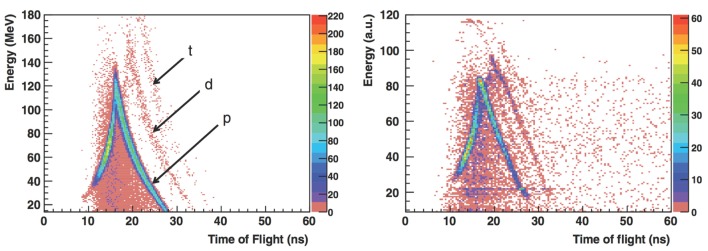
From Ref. (27): energy vs. time of flight (expressed in nanoseconds) distributions obtained for 310 MeV/u carbon ions incident on a 21-cm-thick water target with the telescope located at 30° with respect to the beam direction at 2.2 m from the target center. Left: simulation with Geant v.4 9.2 toolkit, right: measurements (GSI experiment). p, d, and t refer to protons, deuterons, and tritons in the simulated distributions (the background events are mainly due to fragmentation reactions in the scintillator). © Institute of Physics and Engineering in Medicine. Reproduced by permission of IOP Publishing. All rights reserved.